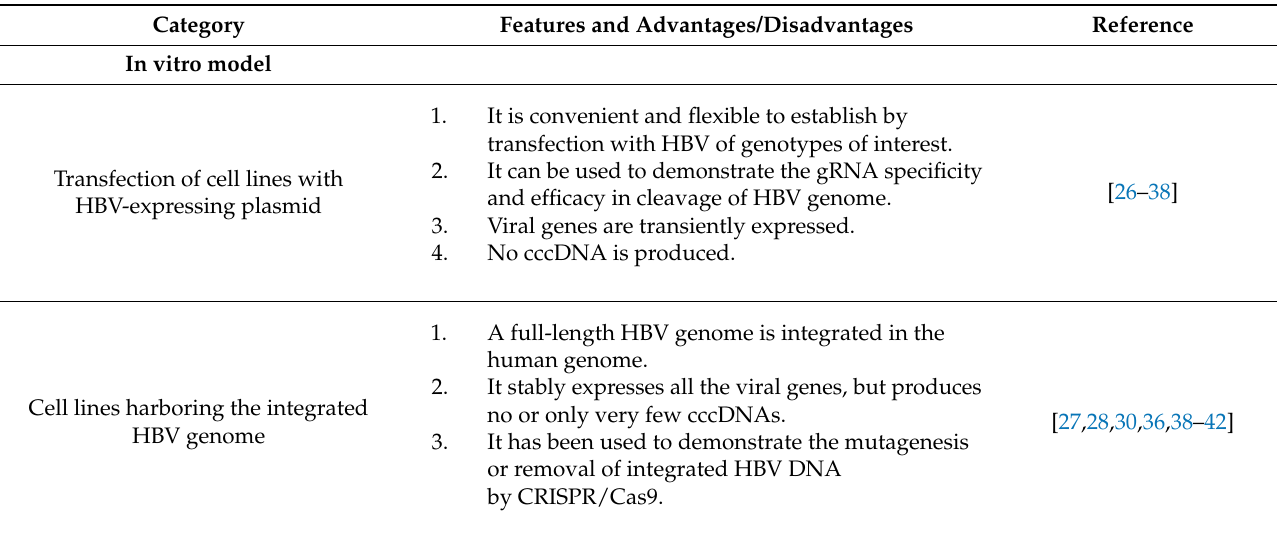
Table 1. In vitro and in vivo HBV models for studying the effects of CRISPR-Cas9-mediatd gene